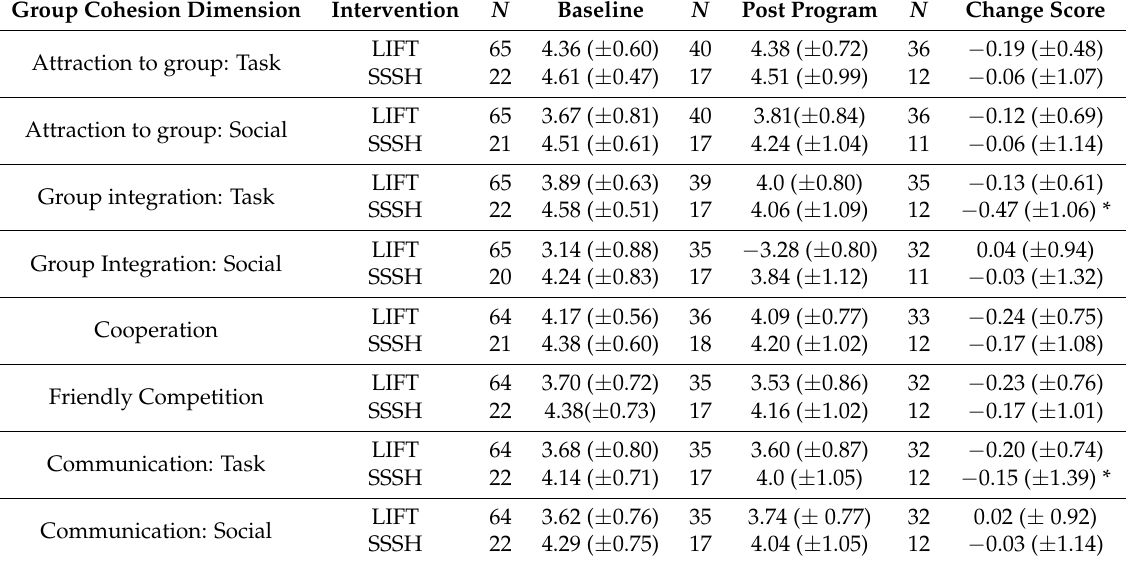
Table 4. Pre- and post-program physical activity group environment questionnaire change scores on a 5-point Likert scale, by